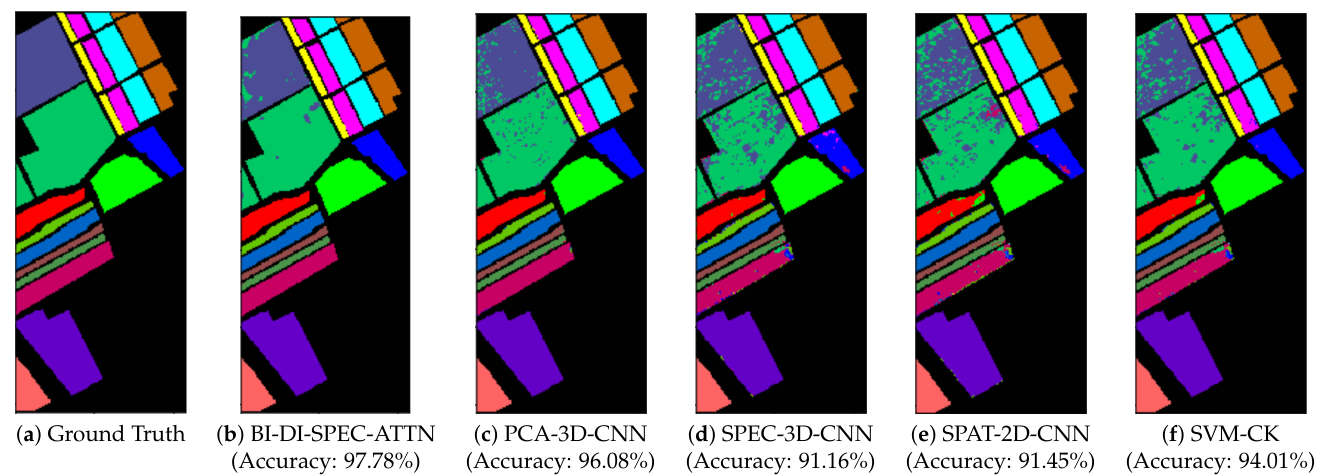
Figure 2. Classification maps of Salinas dataset for all proposed methodologies using 10% of train- ing